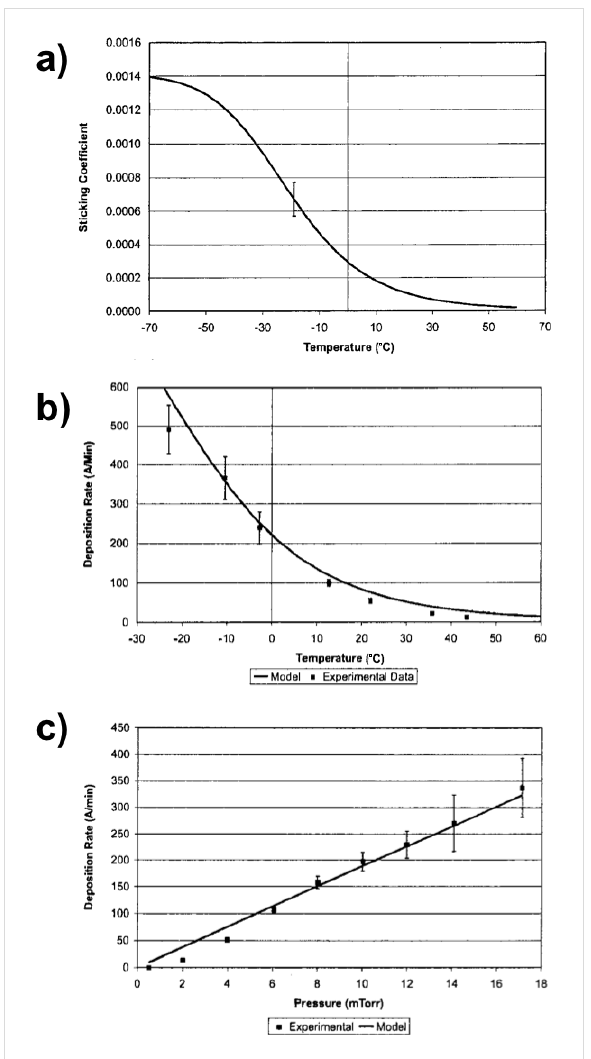
Figure 3: a) Sticking coefficient of p -xylylene diradicals as a function of temperature, b) deposition rate as function of temperature at pressure = 4.0 mTorr, c) deposition rate as function of pressure at temperature = 22 °C. Adapted with permission from [20], copyright 2002 American Chemical